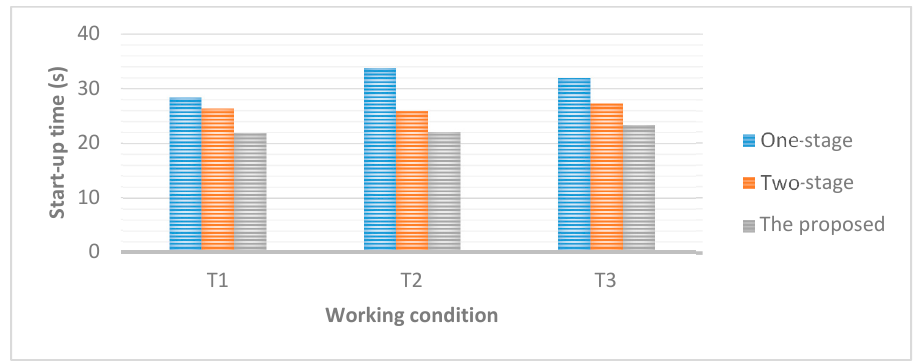
Figure 22. Index of start-up time under different working conditions.